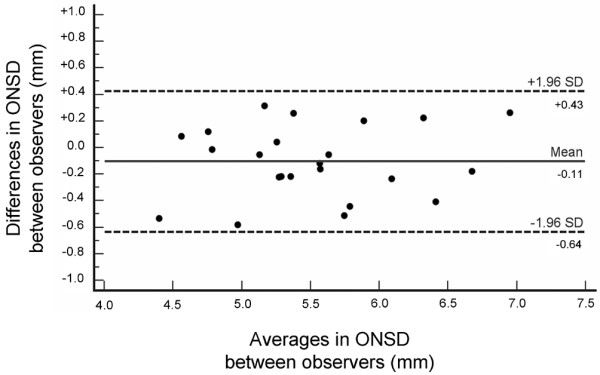
Agreement between observers in measurement of ONSD. Presented is a Bland-Altman [37] graphical representation. ONSD, optic nerve sheath diameter; SD, standard deviation.